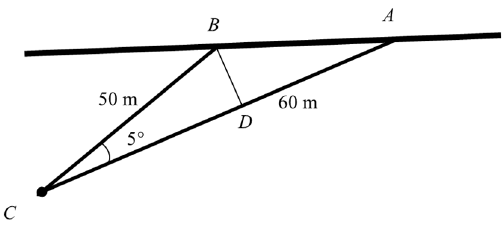
Figure 5. Dividing oblique triangle ABC in the second problem into two right triangles.